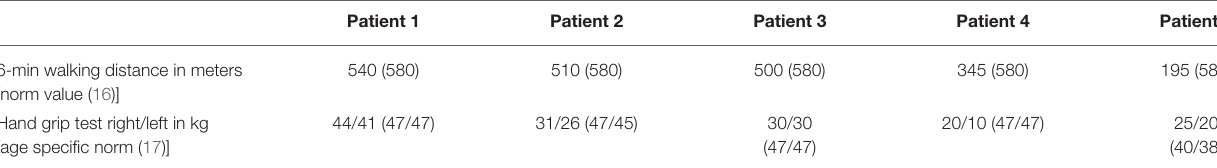
TABLE 3 | Patient functional characteristics.